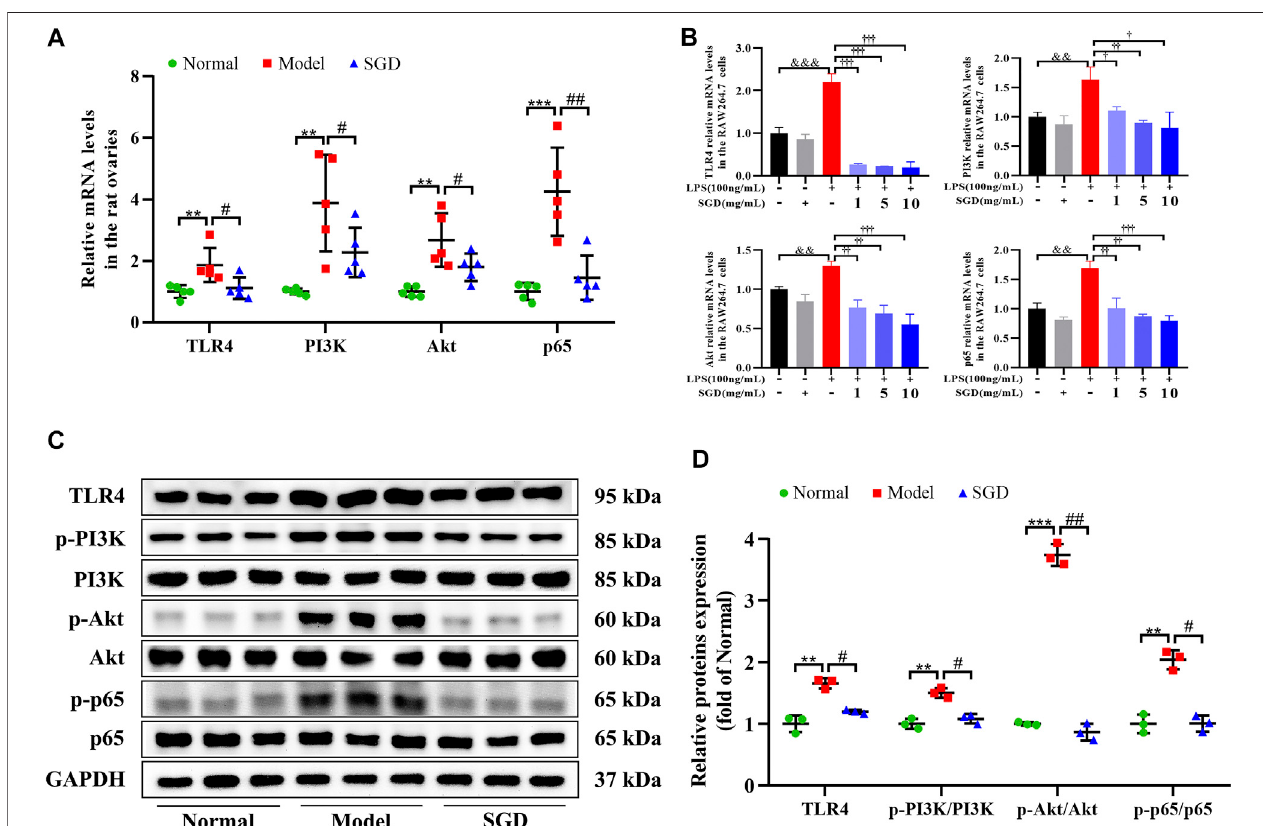
FIGURE 6 | SGD blunted TLR4/NF- κ B signaling pathway in PCOS rats and LPS-stimulated RAW264.7 cells. (A) The mRNA levels of TLR4, PI3K, Akt, and NF- κ B p65 in rats ovarian tissues were quantitated by real-time PCR ( n (cid:1) 5). (B) The mRNA levels of TLR4, PI3K, Akt, and NF- κ B p65 in RAW264.7 cells were quantitated by real-timePCR( n (cid:1) 3). (C,D) TheproteinlevelsofTLR4,p-PI3K,PI3K, p -Akt,Akt,p-p65,andp65inratsovariantissueswerequantitatedbyWesternblotting( n (cid:1) 3).Data were presented as mean ± SEM. ** p < 0.01 vs. normal group, # p < 0.05 and ## p < 0.01 vs. PCOS model group, && p < 0.01 and &&& p < 0.001 vs. the untreated group, † p < 0.05, †† p < 0.01, and ††† p < 0.001 vs. the LPS-stimulated